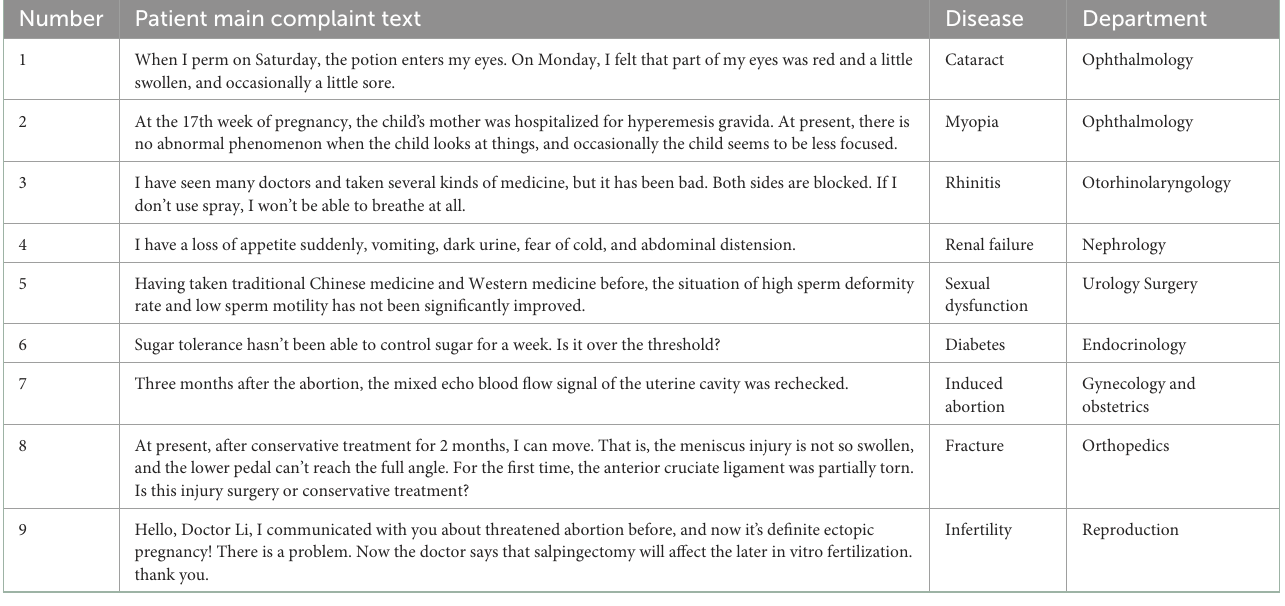
TABLE 1 Patient’s main complaint text.